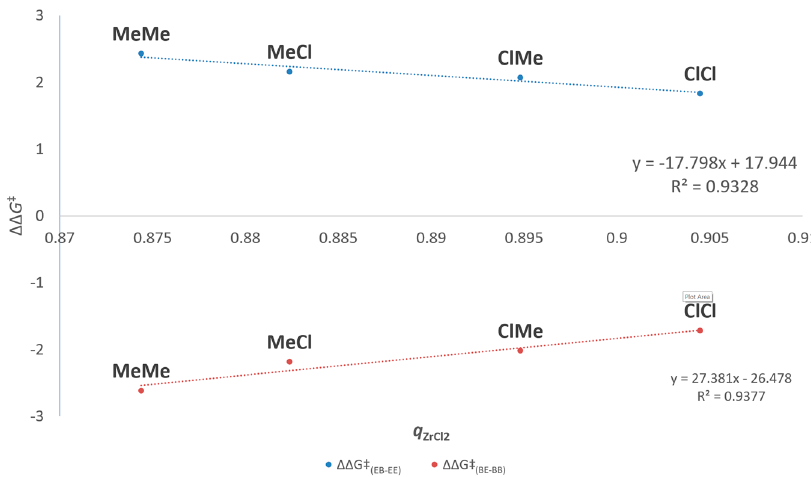
Figure 3. Correlation between ∆∆ G ‡ corresponding to the r -parameters for ethene / 1-butene copolymerization and q ZrCl2 for catalysts R 1 R 2 (see also Table S6).